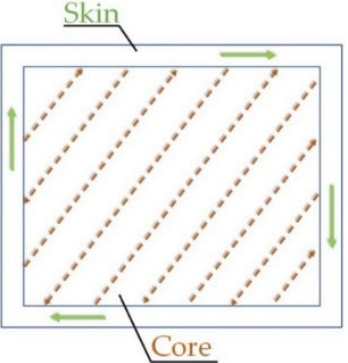
Figure 1. Skin-Core scan strategy used to manufacture AlSi7Mg0.6 and AlSi10Mg0.3 bars and billets. The skin thickness is 200 ± 10 μ m.